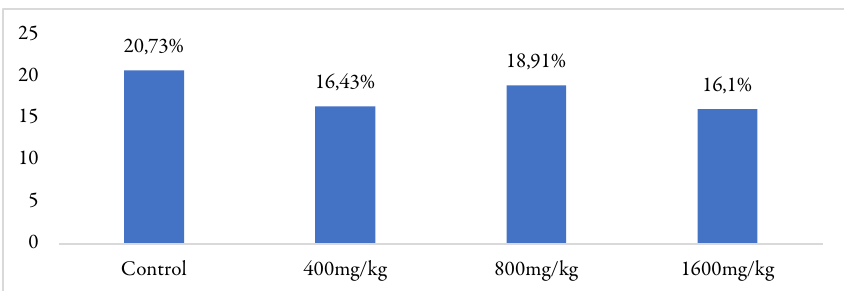
Figure 2. Effect of calabash chalk on body weight of Wistar